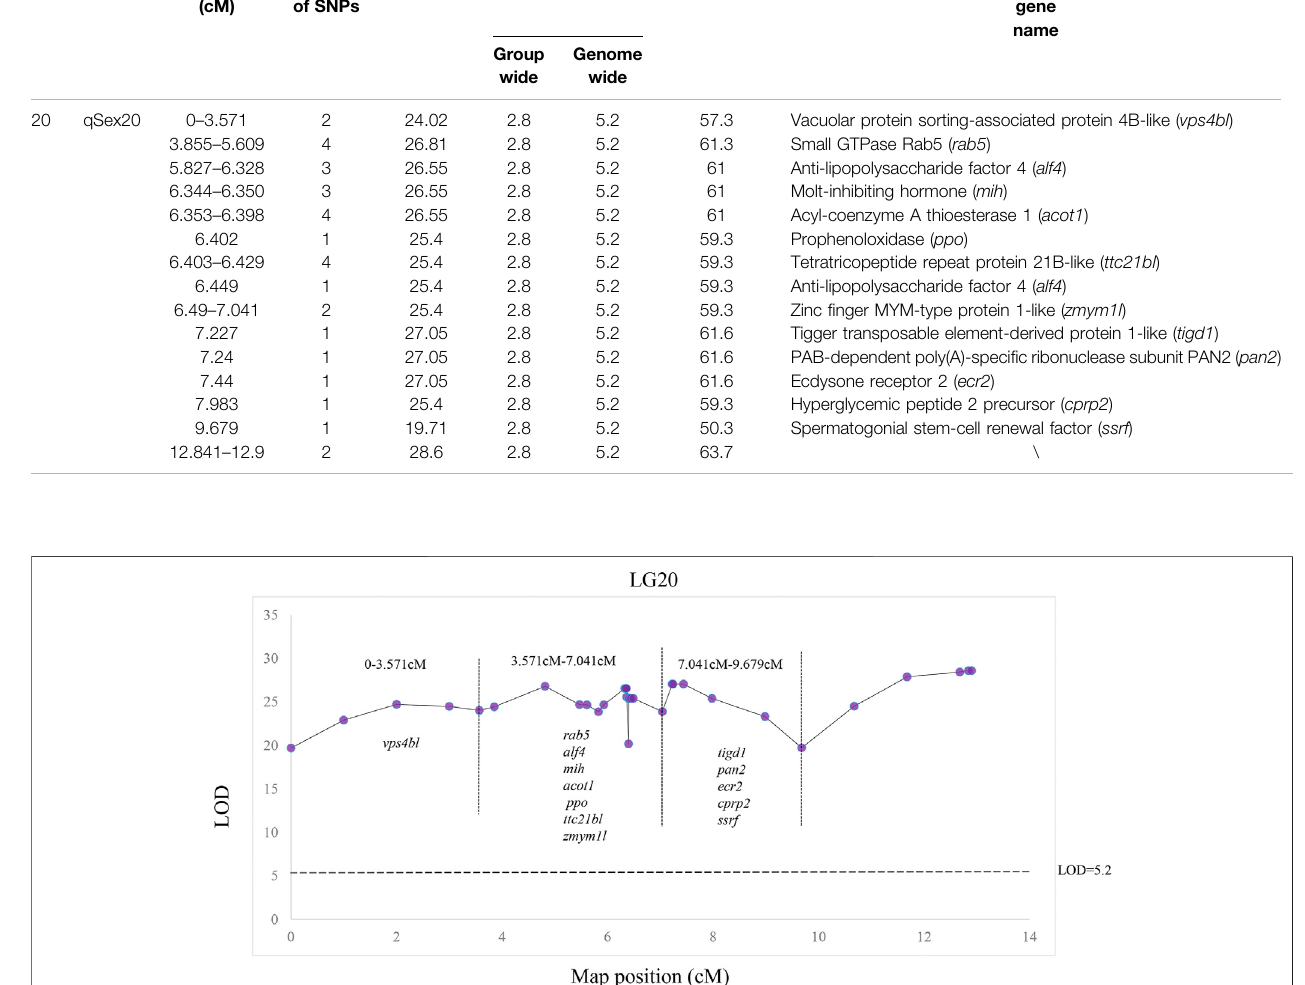
Frontiers in Genetics |